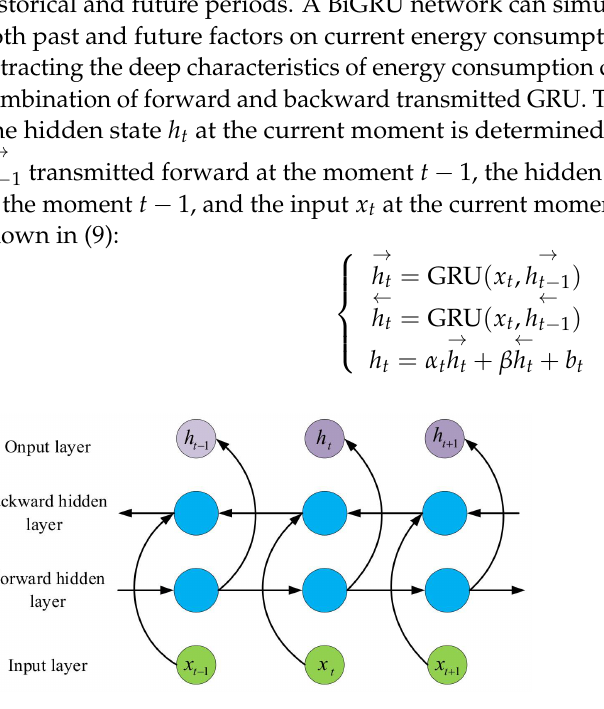
Figure 3. Structure diagram of a BiGRU